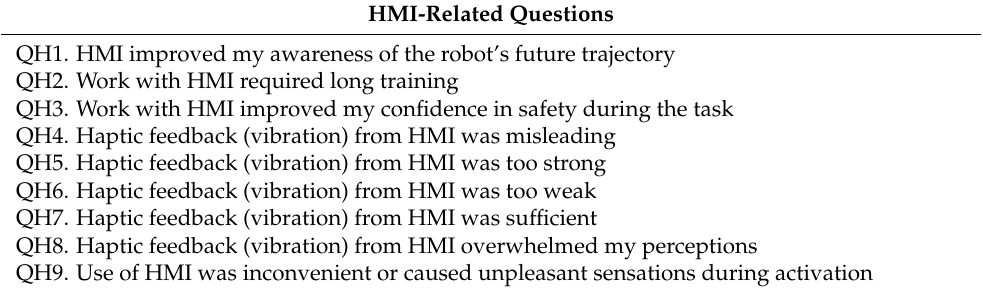
Table 3. HMI-related questions.